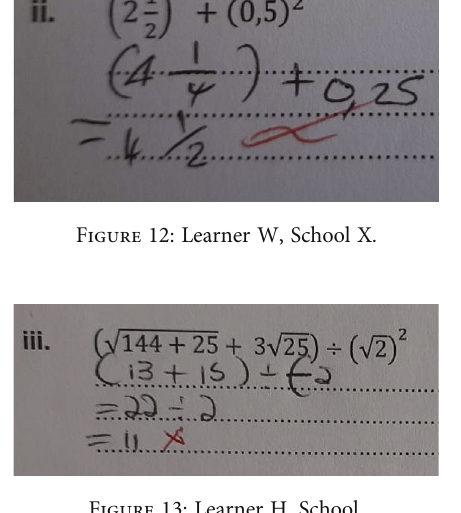
Figure 13: Learner H, School.